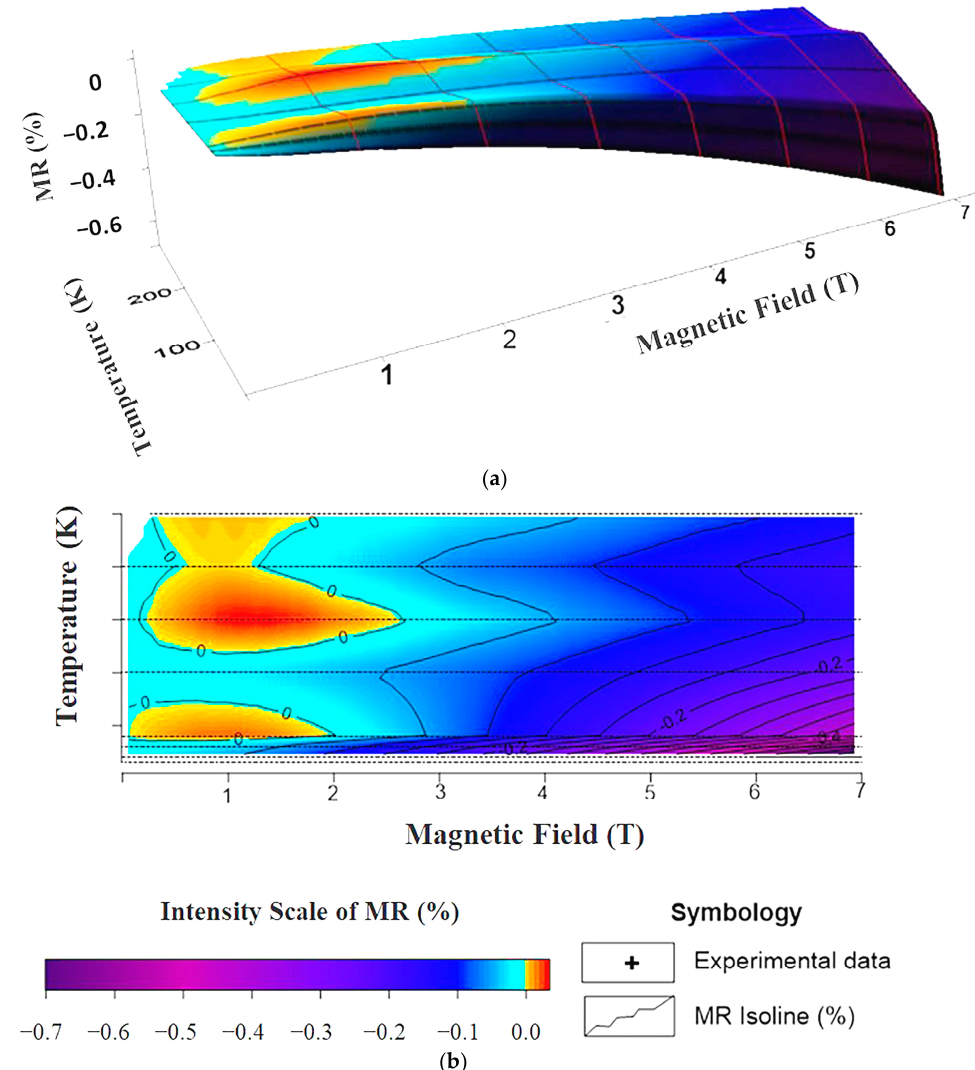
Figure 9. ( a ) Three-dimensional image of the MR in function of the temperature and the magnetic field of Sample II. ( b ) Isoline map of the MR. field of Sample II. ( b ) Isoline map of the